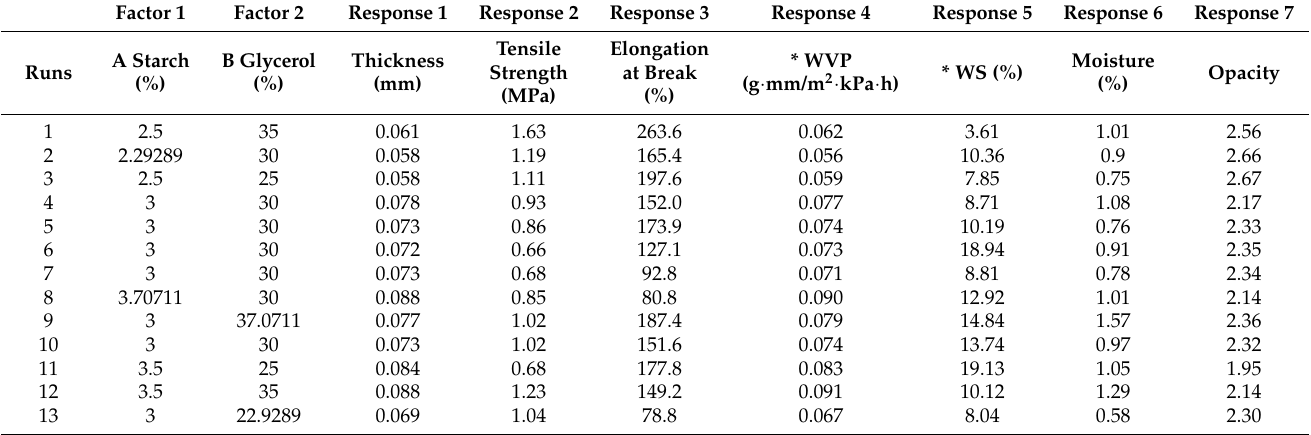
Table 1. Statistical project for the development of biodegradable film from taro peel starch using RSM